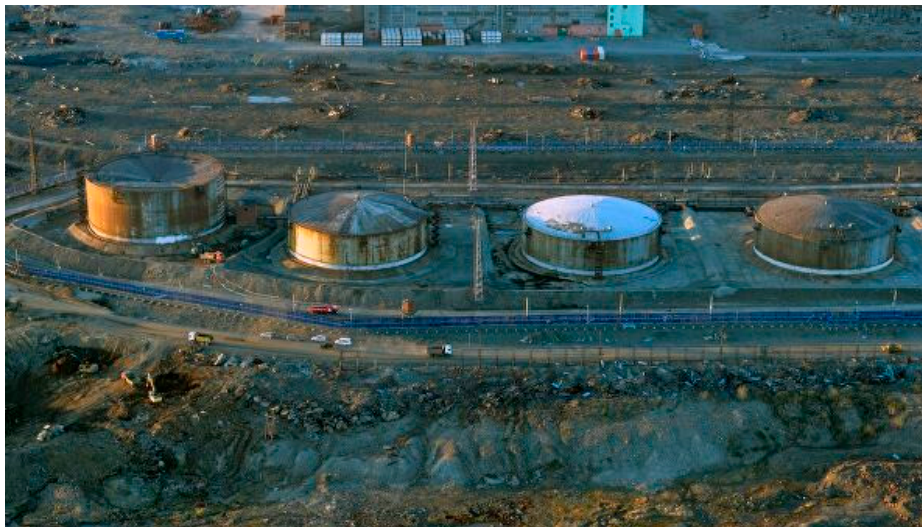
Figure 2. Picture of TPP fuel tanks. View from south-west.